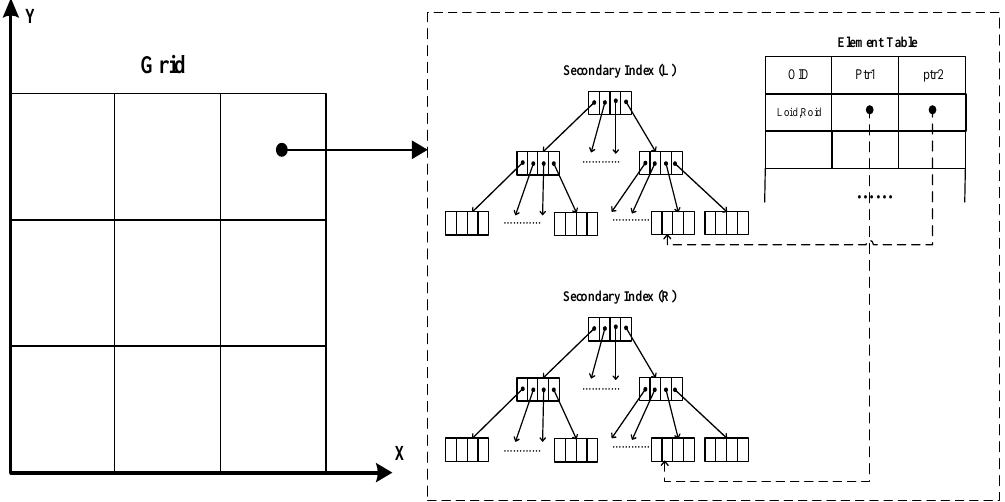
Figure 5. Distributed index.